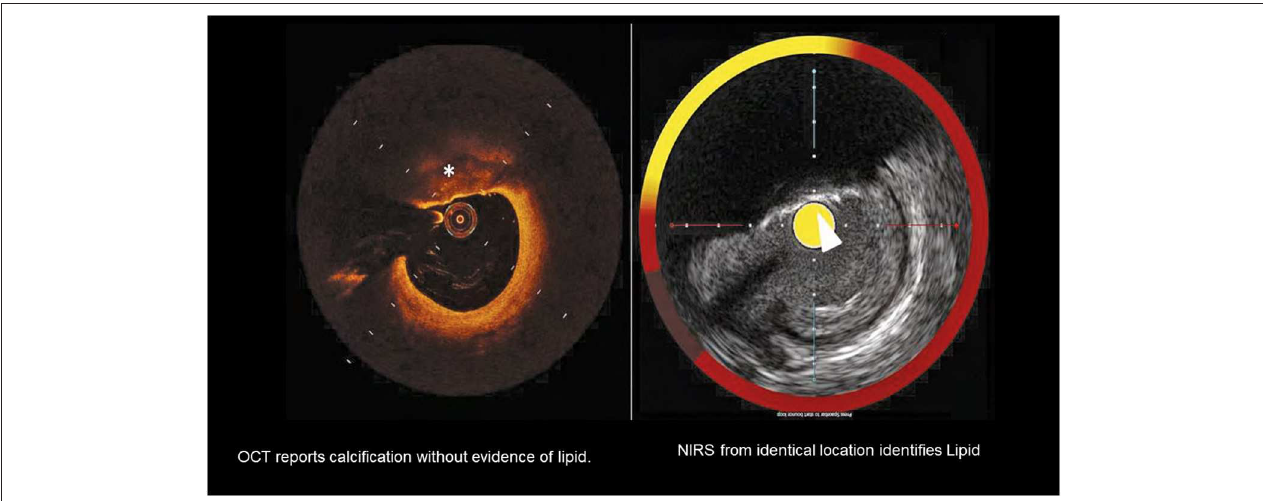
FIGURE 3 | A comparison of OCT detection of lipid with lipid detected by NIRS in the setting of superficial calcification. Calcification is marked by the * on the OCT image and by the arrow on the NIRS-IVUS image. The presence of calcium complicates detection of lipid by